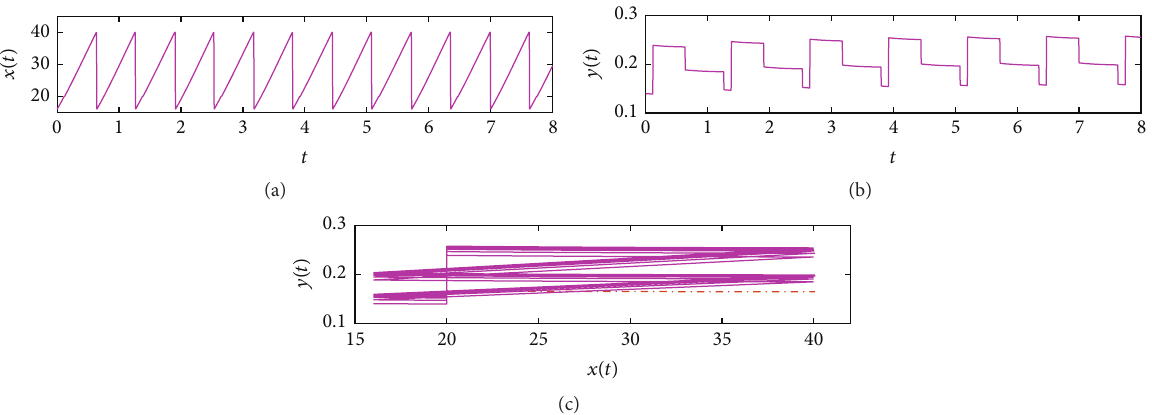
Figure 8: The change in prey density (a), predator density (b), and phase diagrams (c) starting from (𝑥 0 ,𝑦 0 ) = (16, 0.14) with 𝑝 = 0.6 , 𝑞 = 0.2 , = 20 , ℎ = 40 , 𝑦 (ℎ ) = 0.1664 , and 𝛼 ℎ 1 2 𝜏 1